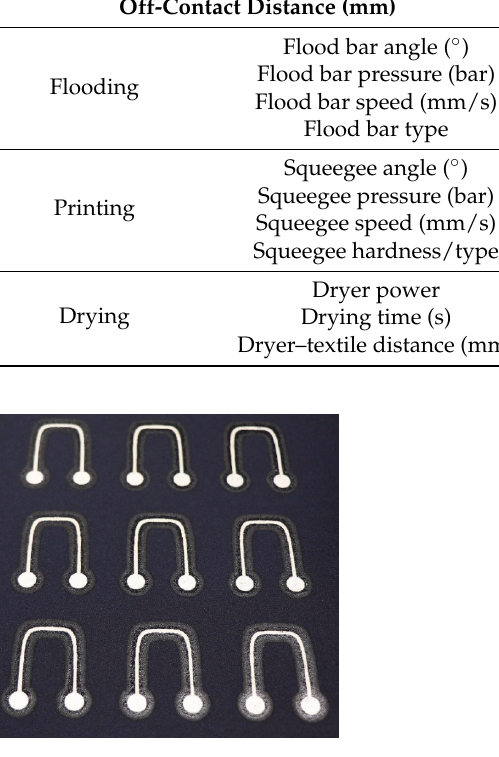
Figure 7. Printed samples.